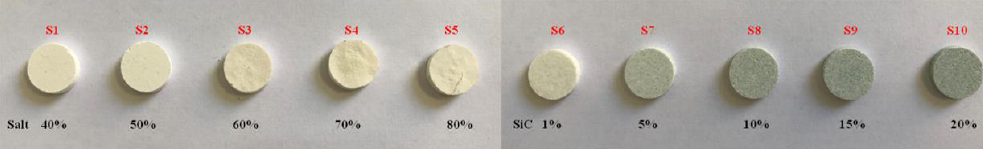
Figure 1. Visual observations of composite PCMs after sintering.